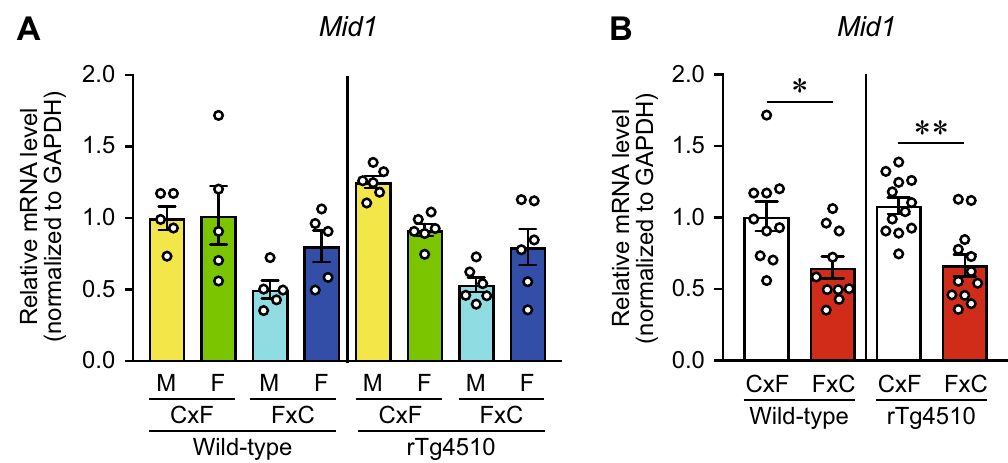
Figure 5. The Mid1 gene may be related to differential accumulation of tau. ( A ) Two-way ANOVA (genetic background × sex) of the qPCR results revealed a main effect of the genetic background, but no effect of sex, on the mRNA levels of Mid1 in WT and rTg4510 mice (Supplementary Table S3). ( B ) The Mann–Whitney U test revealed significantly higher Mid1 mRNA levels in WT_CxF than in WT_FxC mice and in rTg4510_CxF as compared with rTg4510_FxC mice. The WT_CxF and WT_FxC groups contained five males and five females each ( n = 10/group). The rTg4510_CxF and rTg4510_FxC groups contained six males and six females each ( n = 12/group). Data are presented as the mean ± SEM. ** p < 0.01, * p < 0.05 (Mann–Whitney U